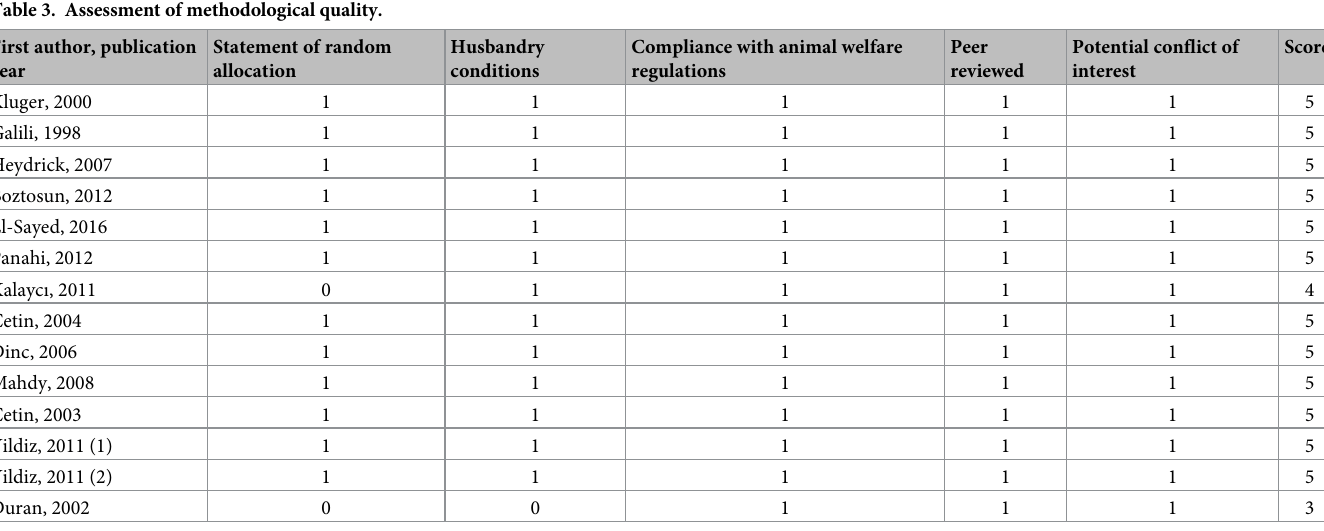
Table 3. Assessment of methodological